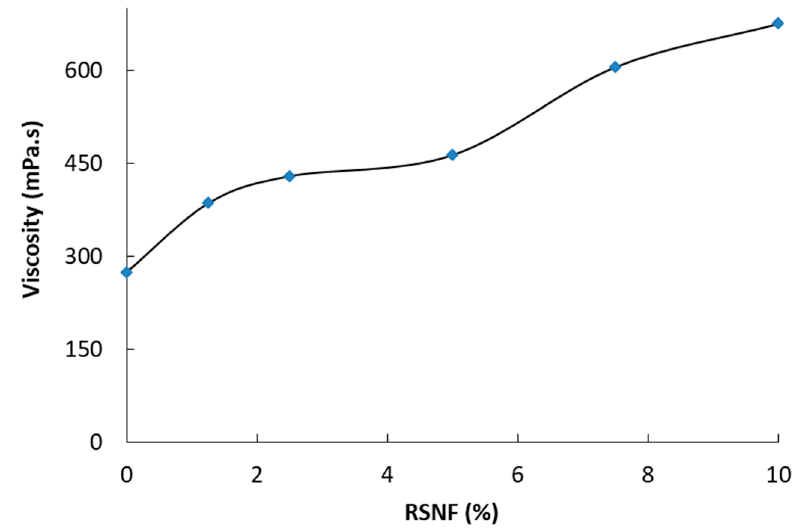
Figure 2. Viscosity of CA solution as a function of RSNF content.